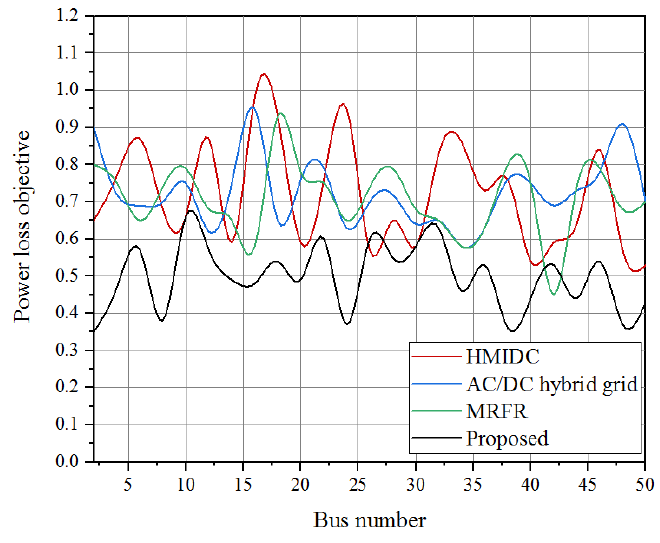
Figure 7. Convergence curves for power loss of IEEE 50-bus system.